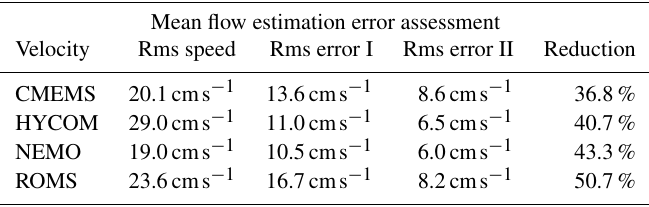
Table 2. An assessment of the errors involved in estimating the time-mean currents from the surface drifter dataset at 1 / 4 ◦ spatial resolution. This is done using velocities from the time-varying altimetric or model velocity fields interpolated along the observed drifter times and positions, with a modification described in the text. The first column shows the root-mean-square magnitude of the time-mean currents, averaged over all times and over all spatial bins for which the corresponding drifter velocity measurement is defined. The second and third columns are the root-mean-square deviation between the “true” time-averaged currents and the estimated currents using either method I, the global average u , or method II, the double average (cid:104) u (cid:105) . The final column is the error reduction in using method II relative to method I.